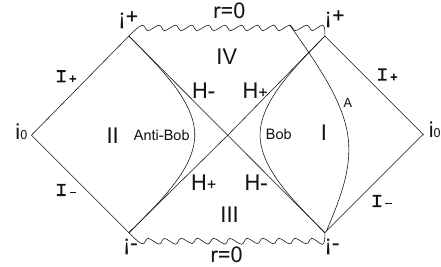
Fig. 1 ThePenrosediagramofSchwarzschildspace-timewhichshows the world-line of Alice, Bob and Anti-Bob. i 0 denotes the spatial infini- ties, i ( i + ) represents time-like past (future) infinity. I − ( I + ) shows light-like past (future) infinity. H ± show the event horizons of the black hole flat space-time [36]. One can see the Penrose diagram of Schwarzschild space-time in Fig.